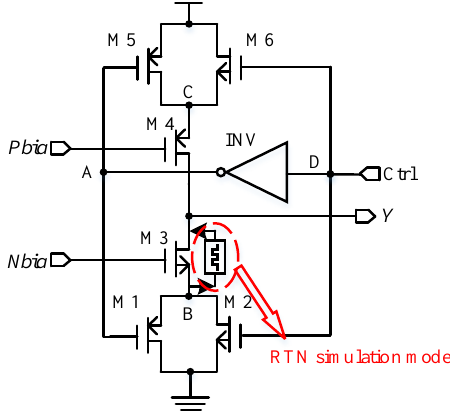
Figure 1. Random telegraph noise (RTN) source circuit structure.